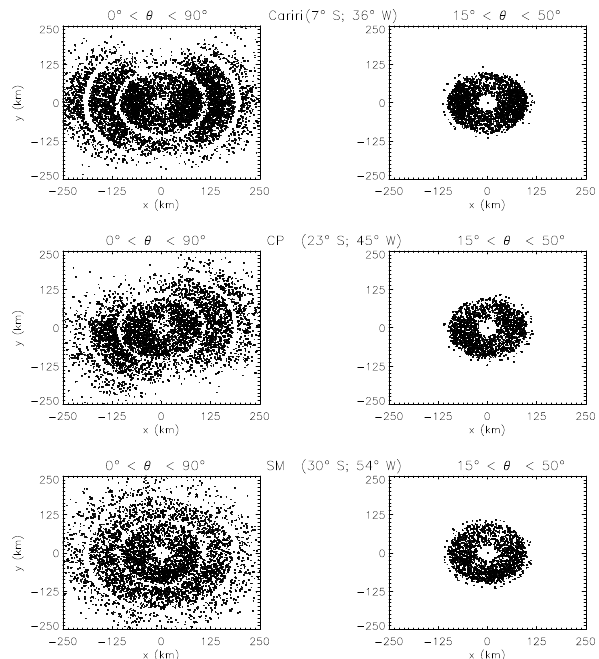
Fig. 4. Daily meteor distributions, for 1 June 2005, illustrating the azimuth patterns of the three Brazilian radars employed in this work. (Left) Meteor distribution including all the zenith angles and (right) only the meteors used in the analysis. The location of each of the radars is listed in each